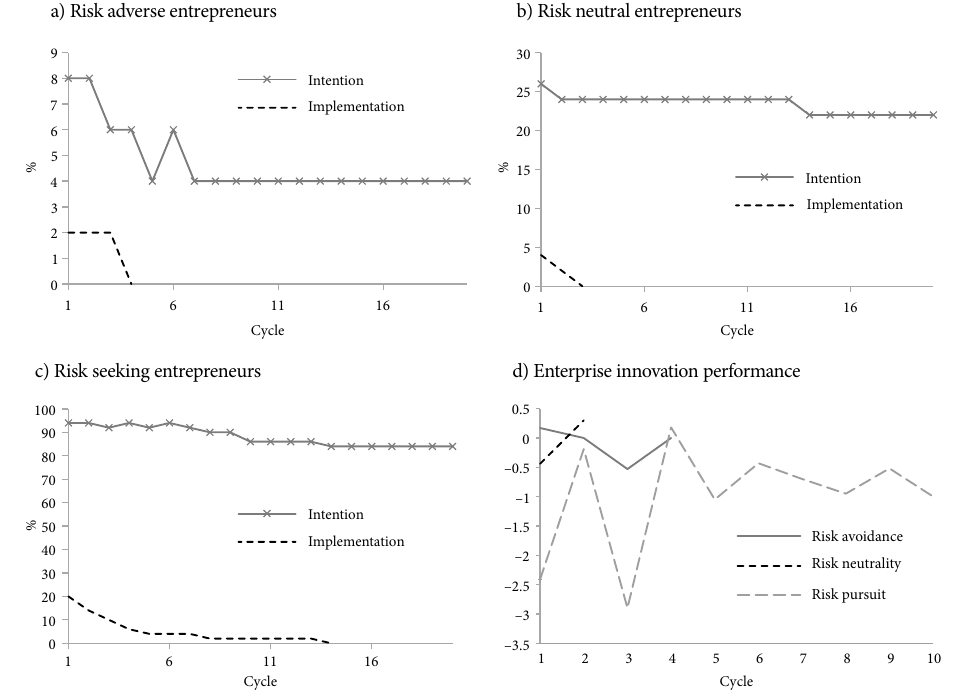
a) Risk adverse entrepreneurs b) Risk neutral